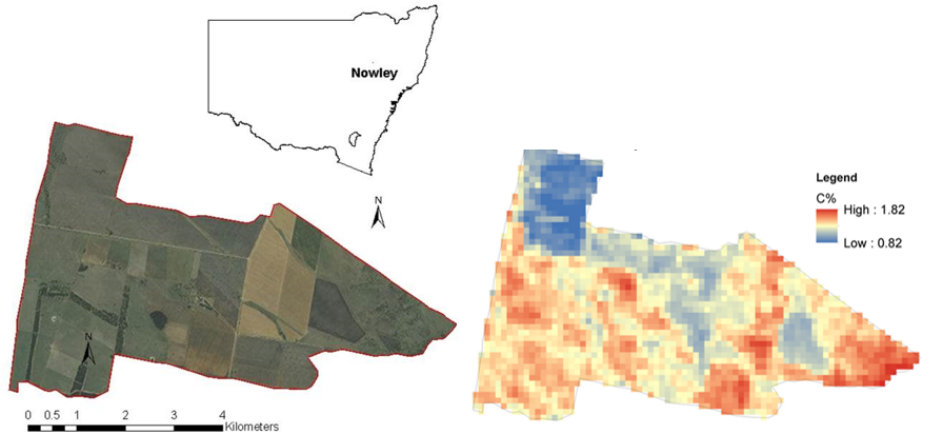
Figure 1. The study area (left; sources: Esri, DigitalGlobe, GeoEye, i-cubed, USDA-FSA, USGS, AEX, Getmapping, AeroGRID, IGN, IGP, Swisstopo, and the GIS user community) and the coarse-scale topsoil soil organic carbon map (right).